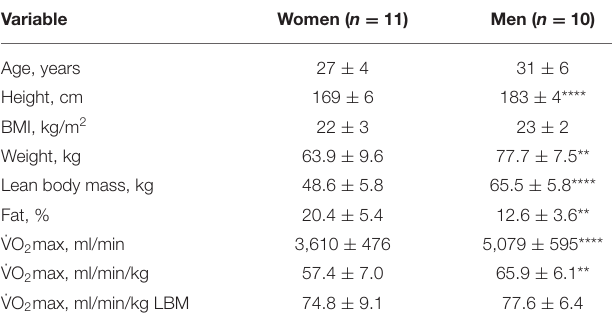
TABLE 1 | Characteristics of participants in this study (women) and from a companion study (men). Variable